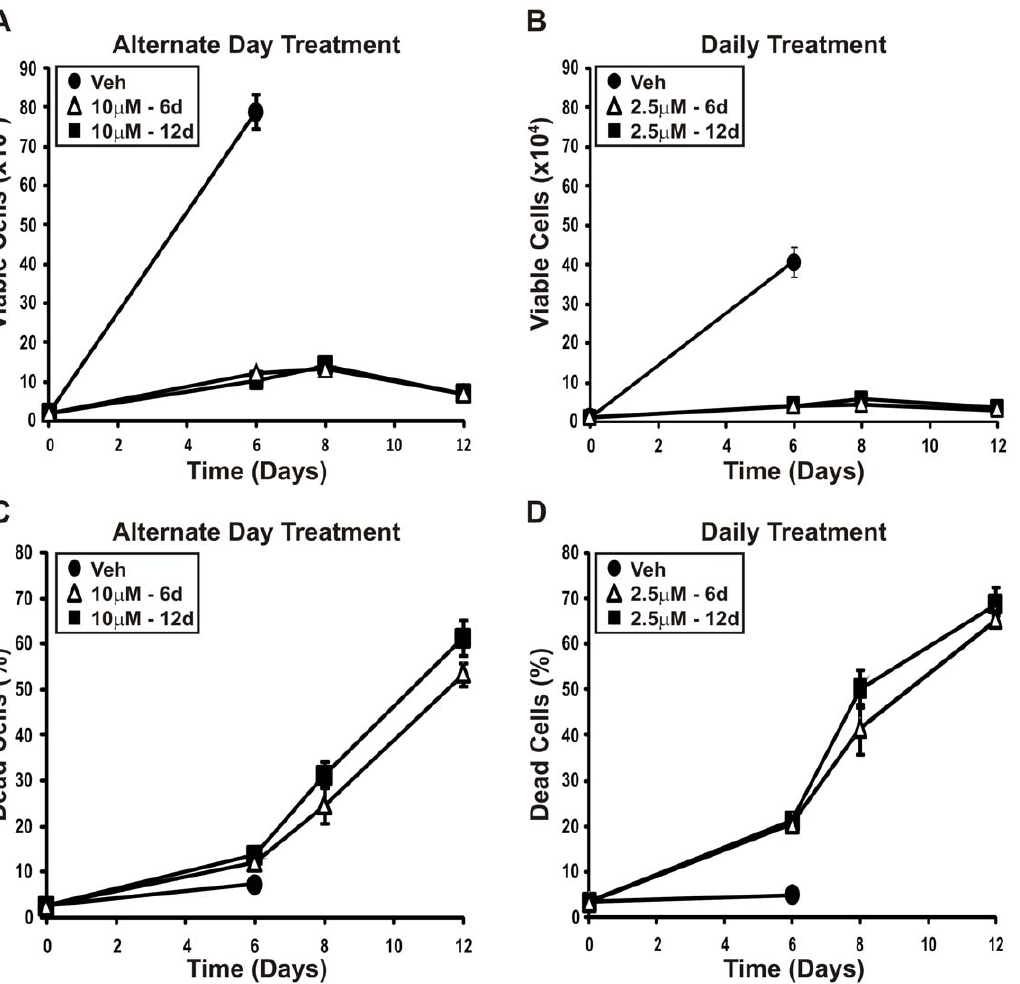
Figure 3. Prolonged alternate day or daily treatment with 5-aza-CdR in LNCaP cells results in similar cell death. (A) and (C) LNCaP prostate cancer cells (2.5 6 10 4 cells per well in 24-well plates) were treated with 10 m M 5-aza-CdR or vehicle control, replenished on alternate days. (B) and (D) LNCaP prostate cancer cells (1 6 10 4 cells per well in 12-well plates) were treated with 2.5 m M 5-aza-CdR or vehicle control, replenished daily. Following 6 days of treatment, control cells were ceased and the remaining cells either continued to receive 5-aza-CdR (10 m M-12d or 2.5 m M-12d, respectively) or received fresh media containing vehicle (10 m M-6d or 2.5 m M-6d). (A) and (C) cells were counted at day 6, 8 and 12 using a hemocytometer and the number of viable cells was assessed by Trypan blue dye exclusion. (B) and (D) the number of dead cells is expressed as a percentage of the total number of cells counted.